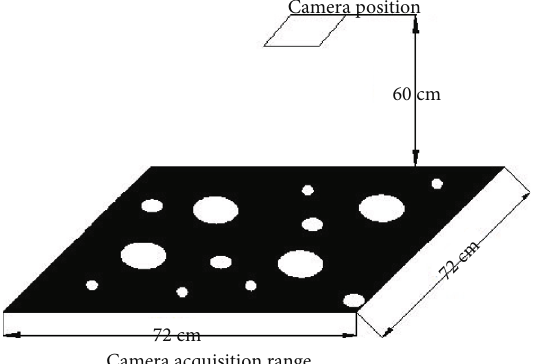
Figure 1: Sketch of pavement image acquisition and calculation.